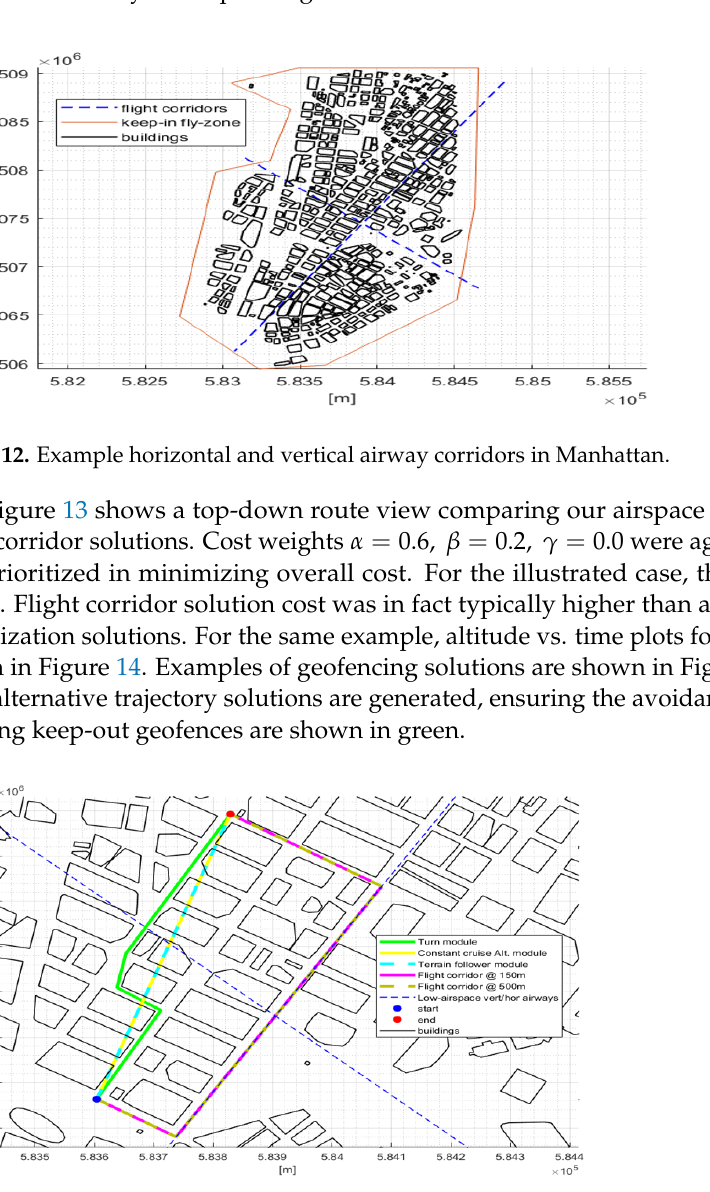
Figure 13. Top-down view of example flight paths for airspace volumization and fixed flight corridor solutions. Distances traveled are 770 m (turn), 1051 m (constant cruise), 1139 m (terrain follower), 1528 (150 m flight corridor), and 1977m (500 m flight